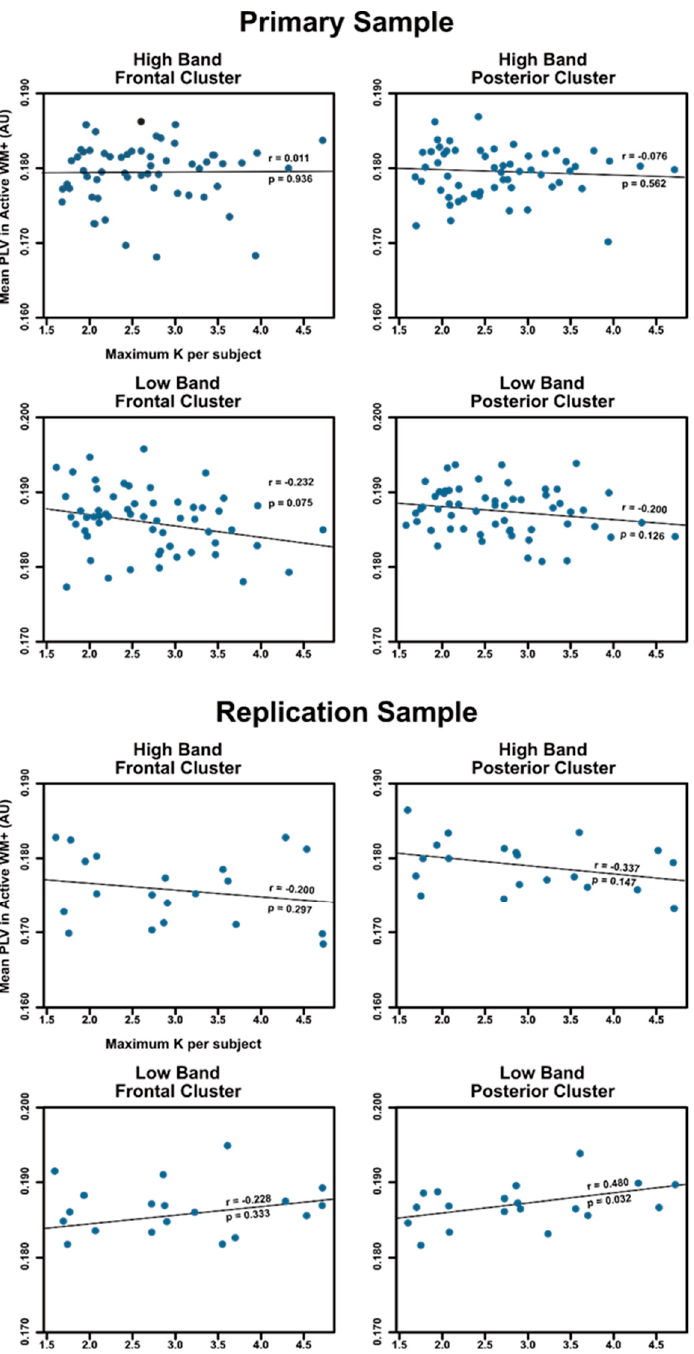
Figure 5. A scatterplot of individual delay period PLV and K, a measure of working memory capacity for the main sample ( left ), and the replication sample ( right ). The correlation for and p -value for each sample are noted on the graph, as well as the line of best fit.